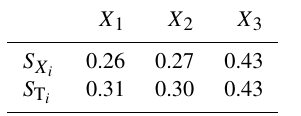
and f min , 1 2 ,f min ) 1 2